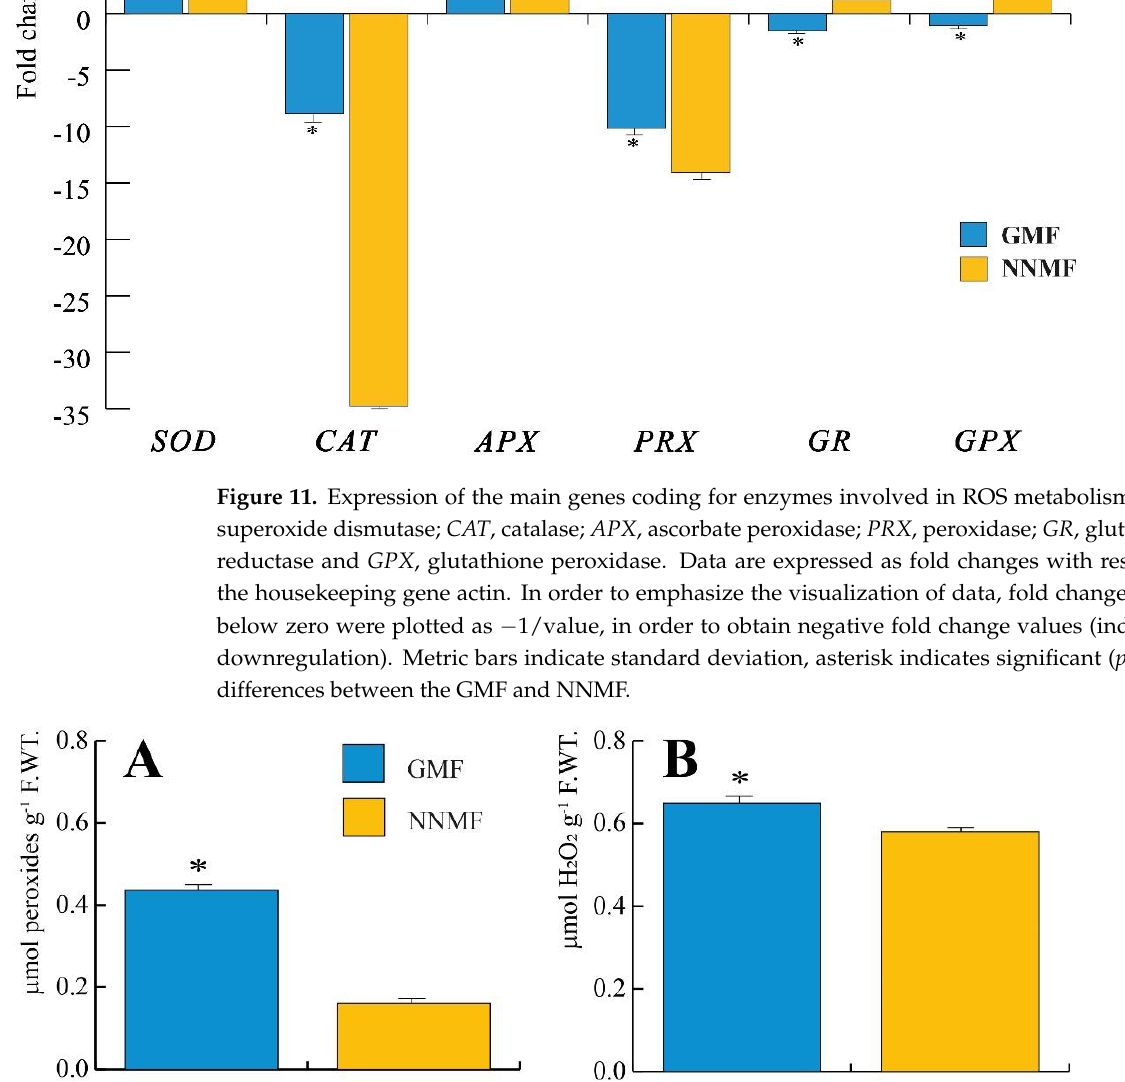
Figure 12. Production of total peroxides ( A ) and H 2 O 2 ( B ) in Lima bean plants exposed to GMF and NNMF conditions. Metric bars indicate standard deviation, asterisk indicates significant ( p < 0.05) differences between GMF and NNMF.